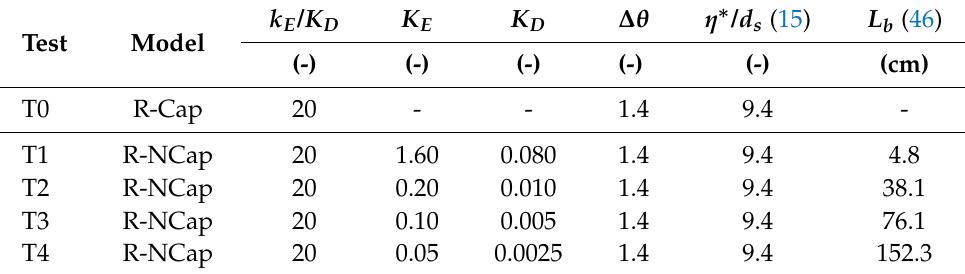
Table 6. Noncapacity setup for the analysis of the R-NCap model’s behavior.